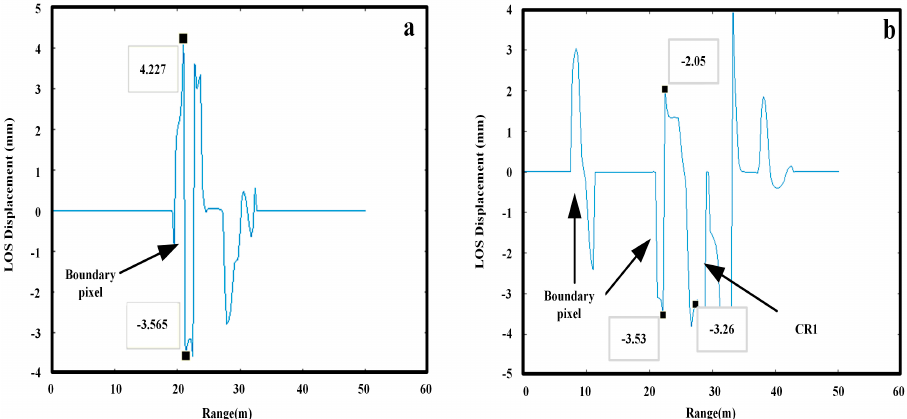
Figure 15. 1D profiles including abnormal discontinuous boundary and CR1. The abnormal bumps are in the range direction of the displacement map ( a ) An example profile contains boundary pixel; ( b ) Profile contains boundary pixel and CR1.